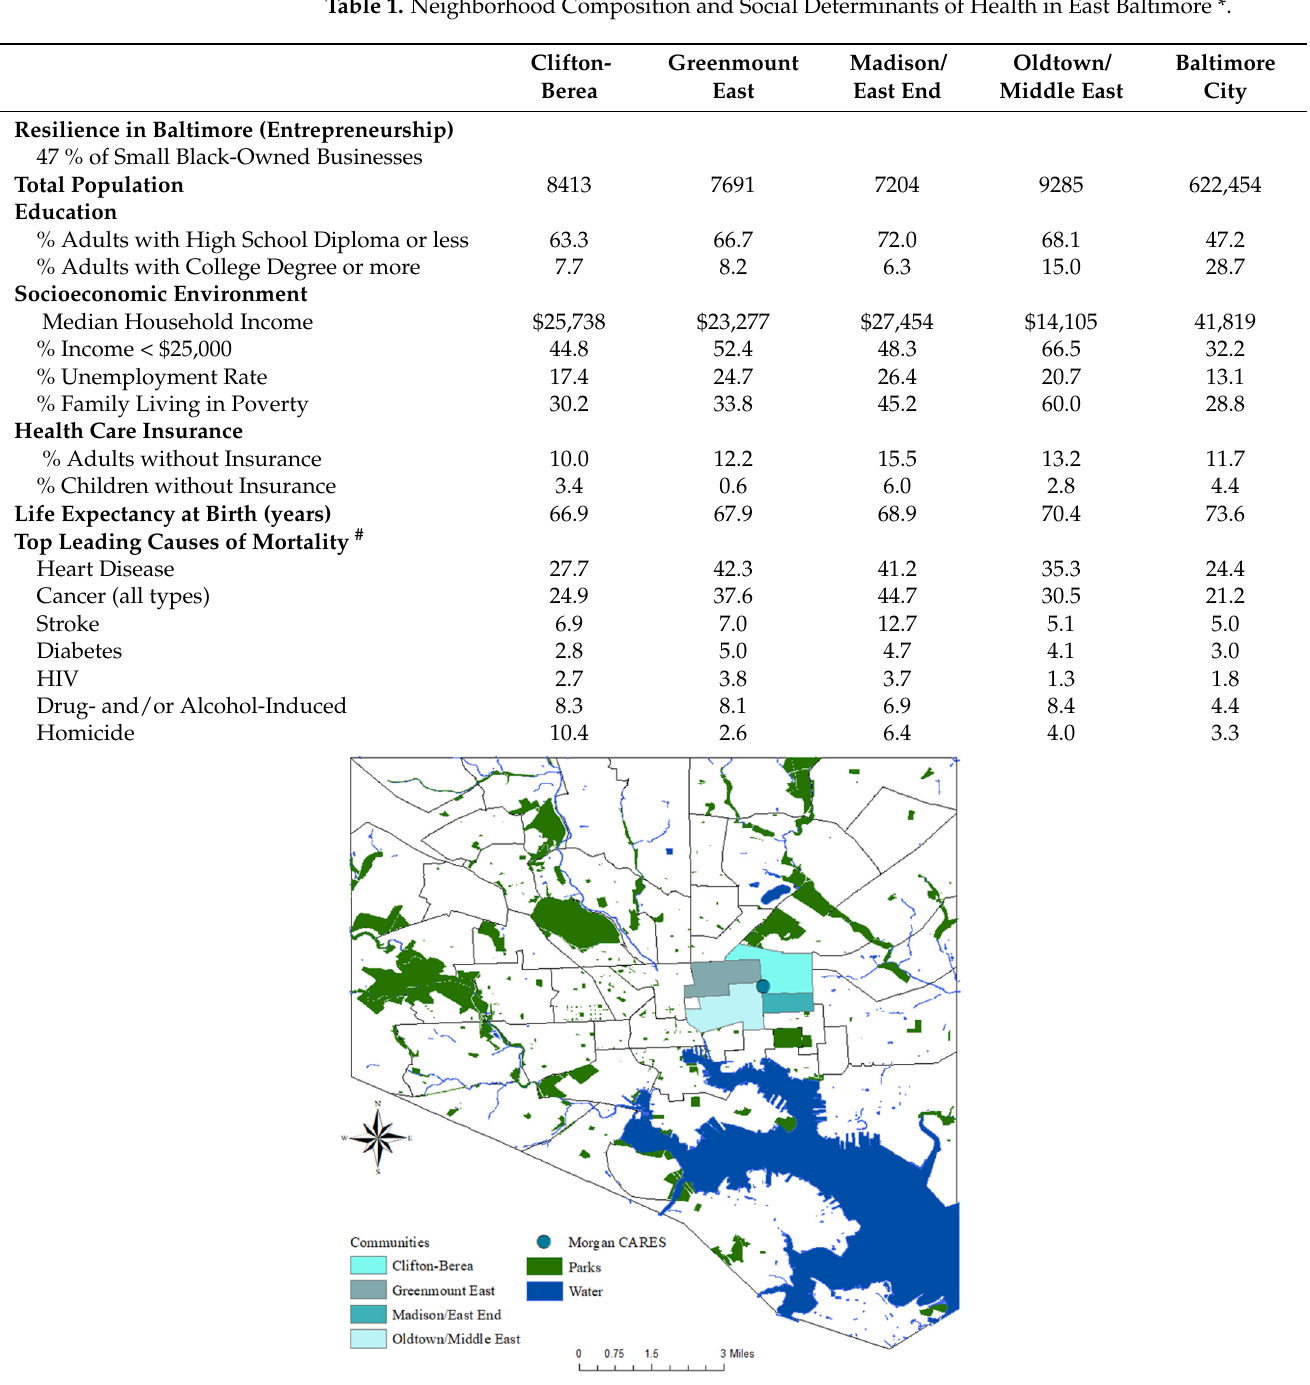
Table 1. Neighborhood Composition and Social Determinants of Health in East Baltimore *. Clifton-Berea